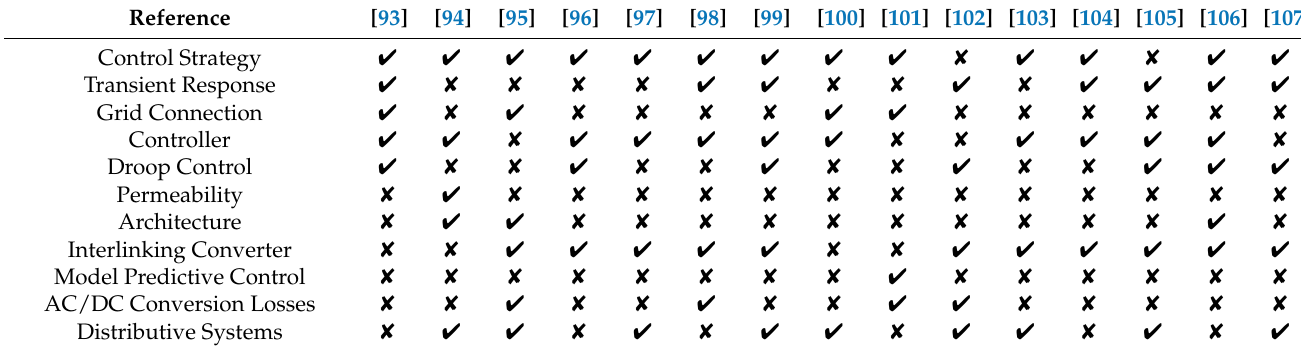
Table 3. Discussion of different aspects in the literature review of generation control.